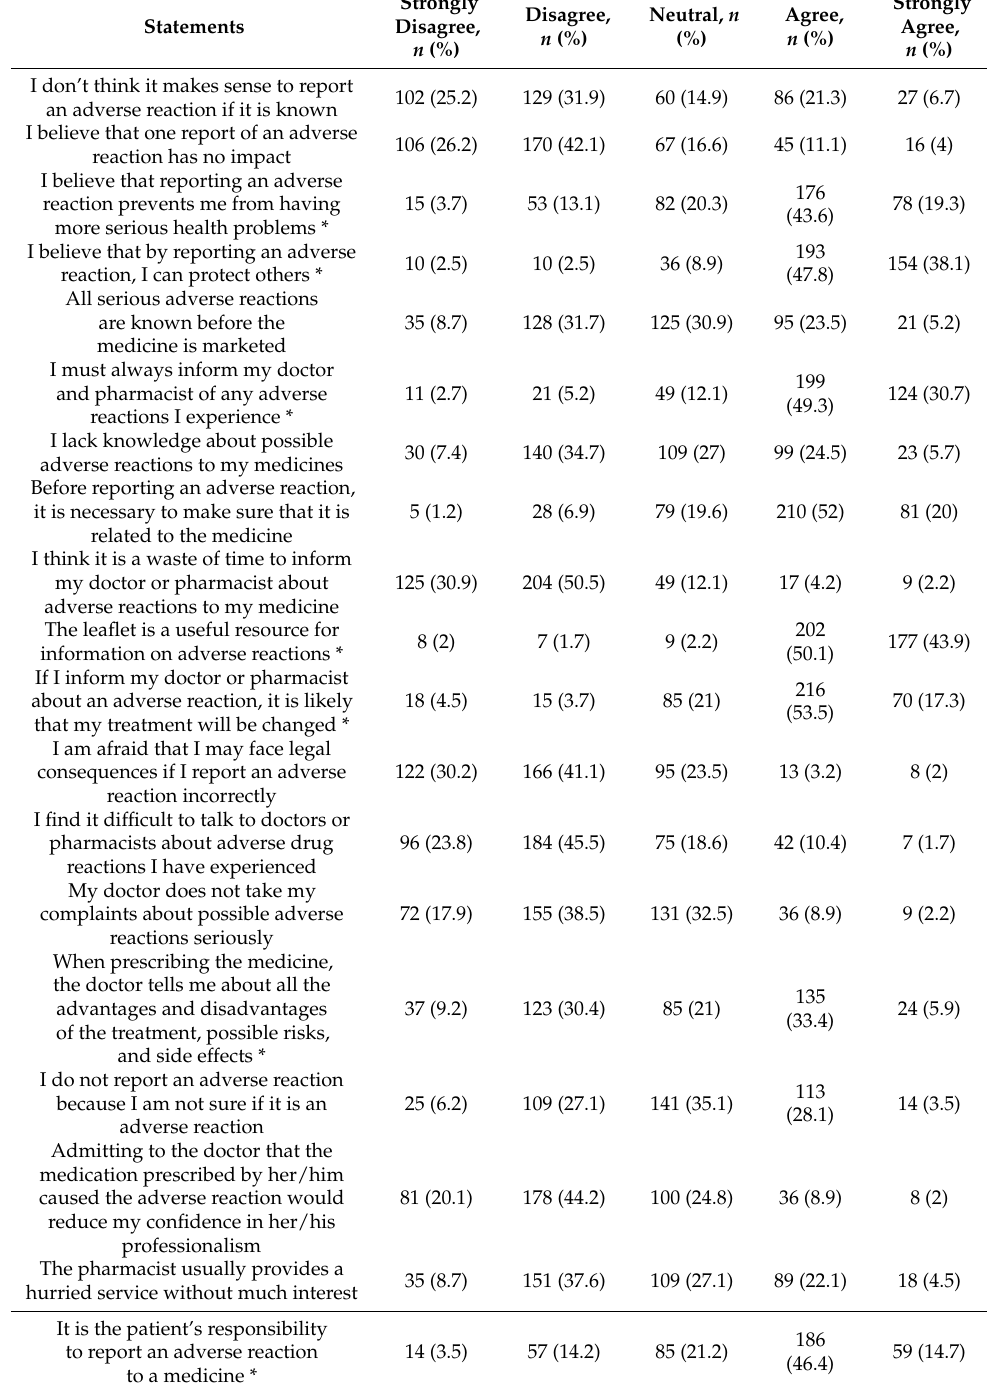
Table 3. Attitudes of patients’ towards pharmacovigilance and adverse drug reaction